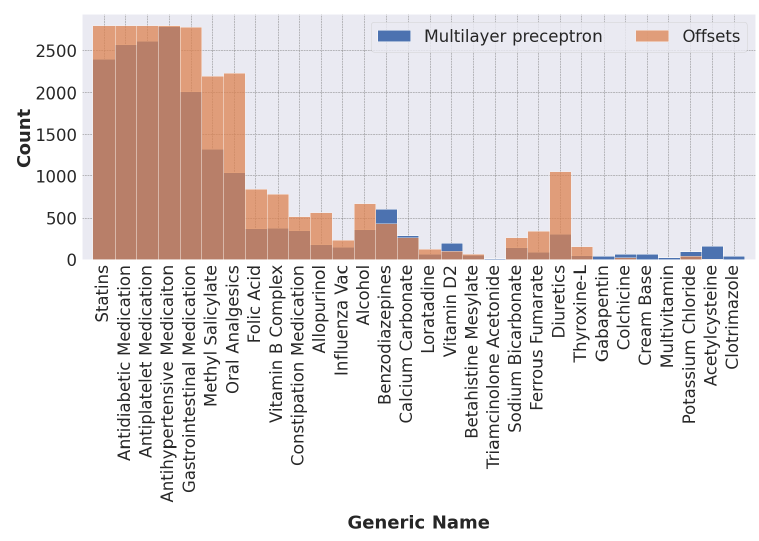
Figure 5. Distribution of recommended drugs in the test